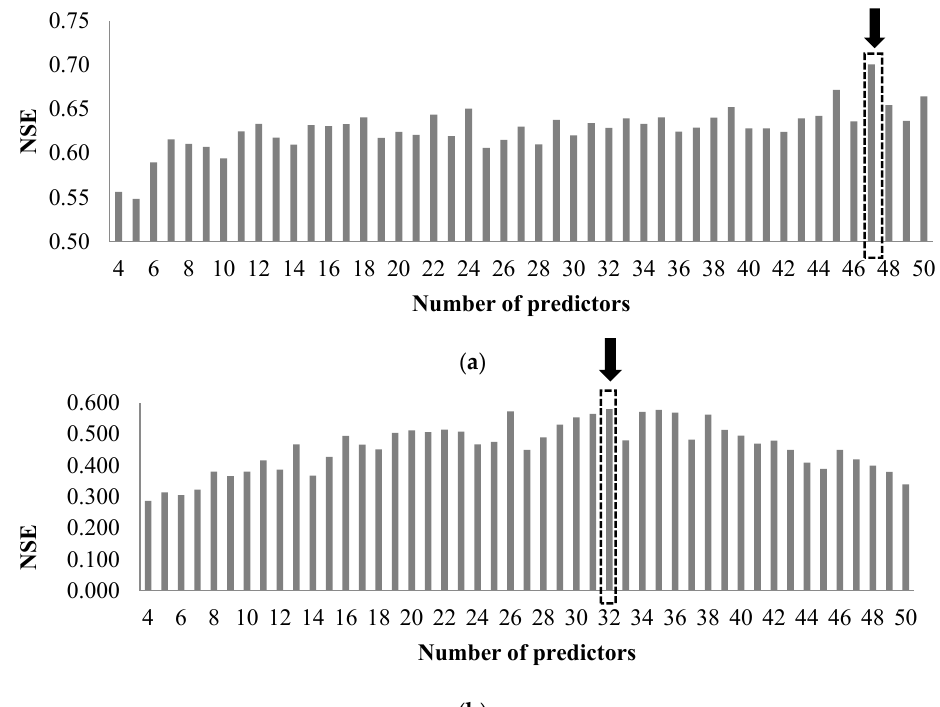
Figure 4. Variation of evaluation metric CE against increasing the number of predictors for simulation of ( a ) RCU and ( b ) RMAX with ANN model.